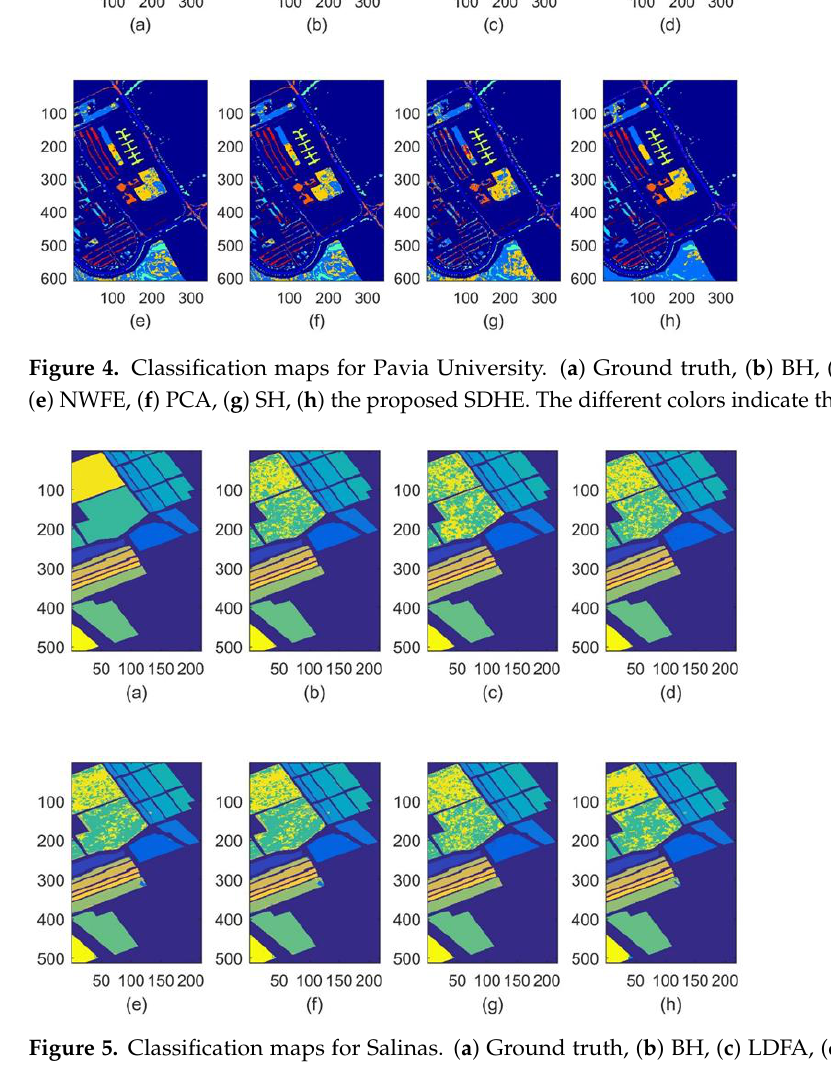
Figure 6. Classification maps for KSC. ( a ) Ground truth, ( b ) BH, ( c ) LDFA, ( d ) LPP, ( e ) NWFE, ( f ) PCA, ( g ) SH, ( h ) the proposed SDHE. The different colors indicate the different classes. To research the DR effectiveness on the different sizes of training sets, we randomly selected 15, 20, or 25 samples per class as the training set, and the rest samples were re- garded as the testing set, respectively. Then the related experimental results, including OA (%) and STD for the three hyperspectral data sets are listed in Tables 7 – 9. Table 7. Classification accuracy (%) at 30-dimensionality for the different sizes of training sets in Pavia University. Method